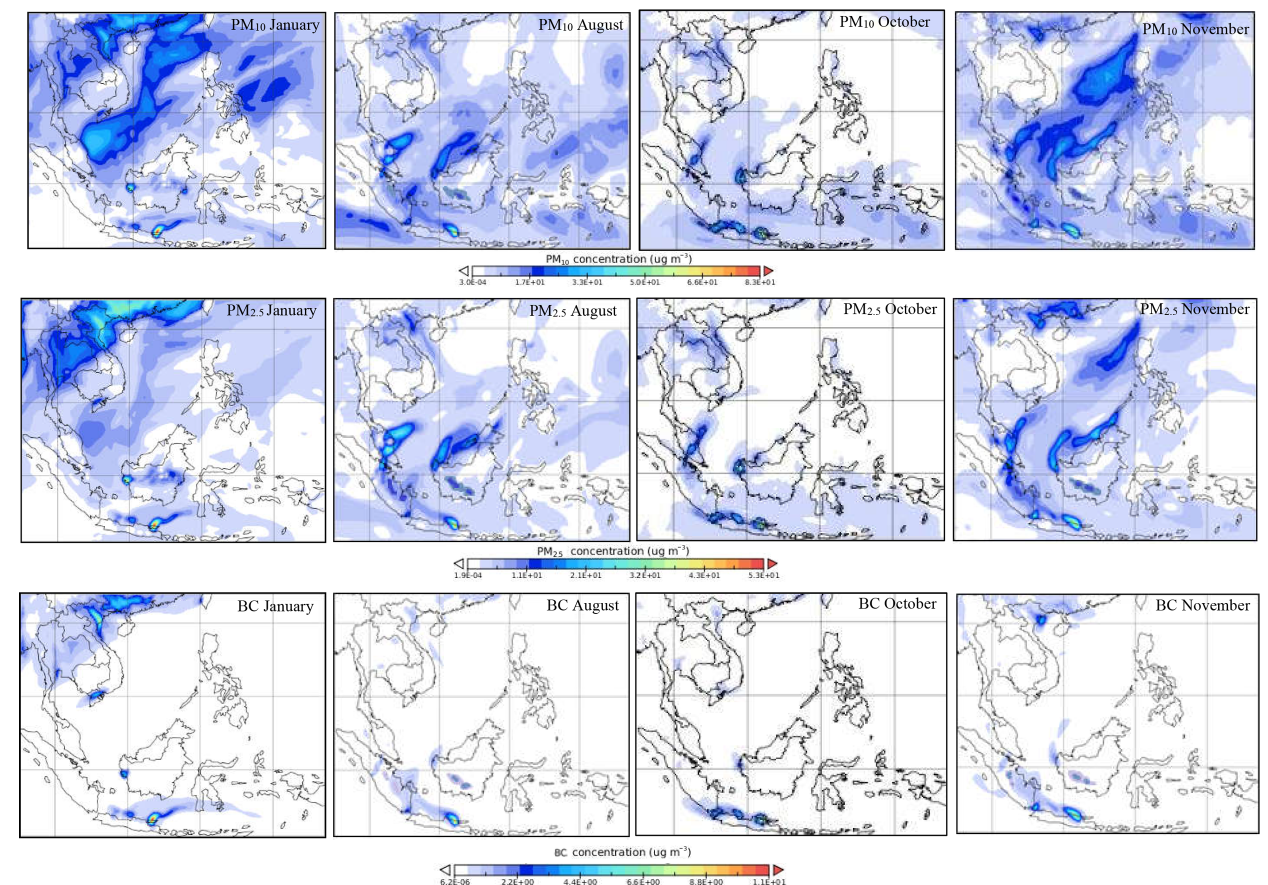
Figure 7. Spatial distribution of monthly average PM 10 , PM 2 . 5 , and BC in the selected months,